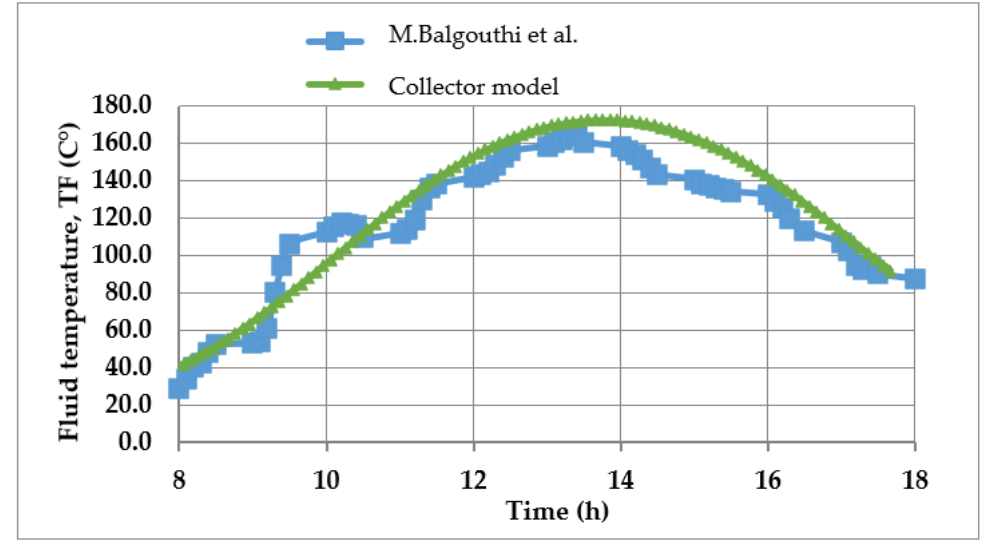
Figure 6. Validation of the PTC fluid temperature [65].